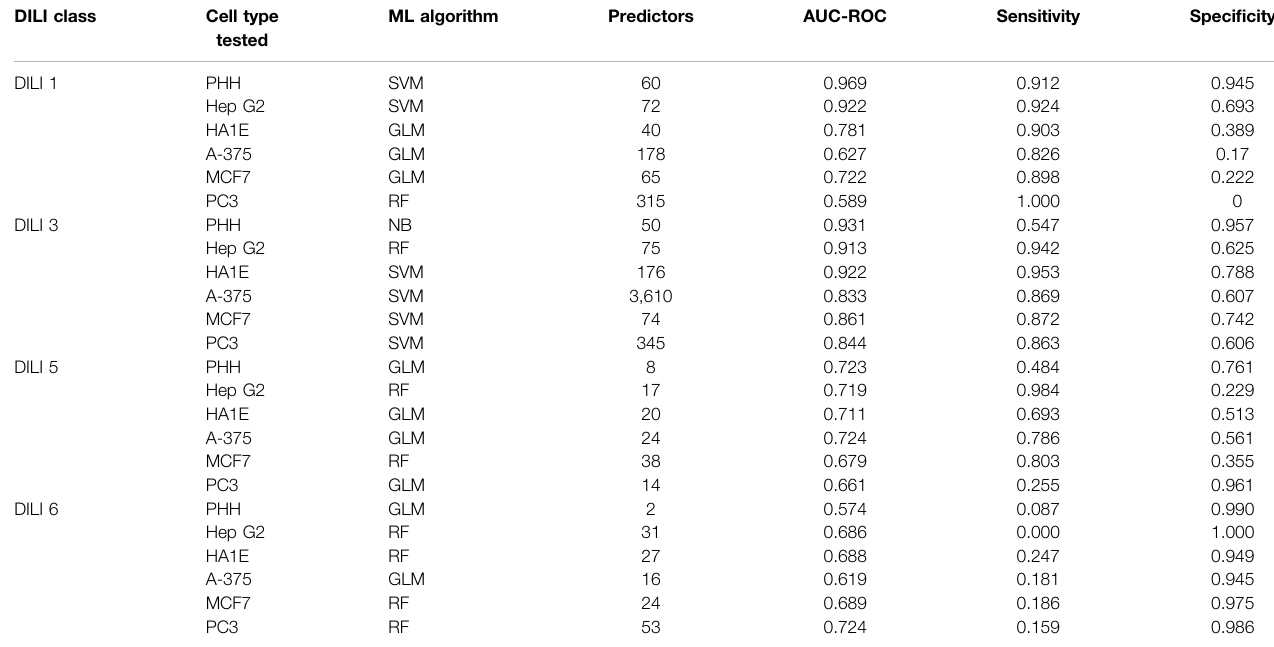
TABLE 4 | Training Performance on Independent Cell Line based Models. Each of the six cell lines with L1000 expression data were used to build predictive models of the four DILI classes. Training performance results for the best performing model for each cell type and DILI class are shown as well as the number of predictors following feature selection as described in the methods